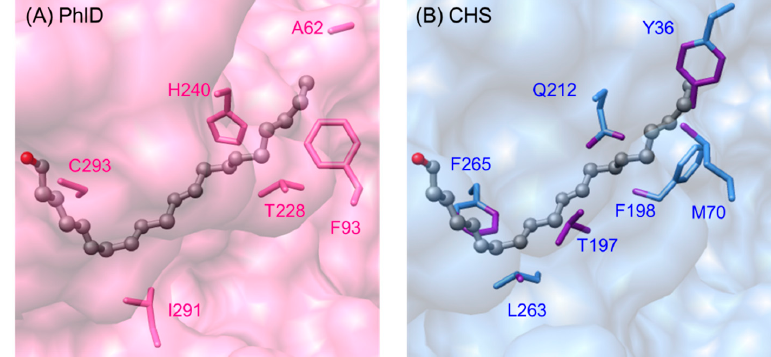
Figure 10. Surface view of arachidonic acid—( A ) on the acyl-binding tunnel in E. siliculosus PhlD (PDB ID: 4B0N) and ( B ) superimposed on M. sativa CHS (PDB ID: 1CHW). Clashes between the corresponding residues in CHS that line the “tunnel” and arachidonic acid were observed (indicated by purple bonds on the